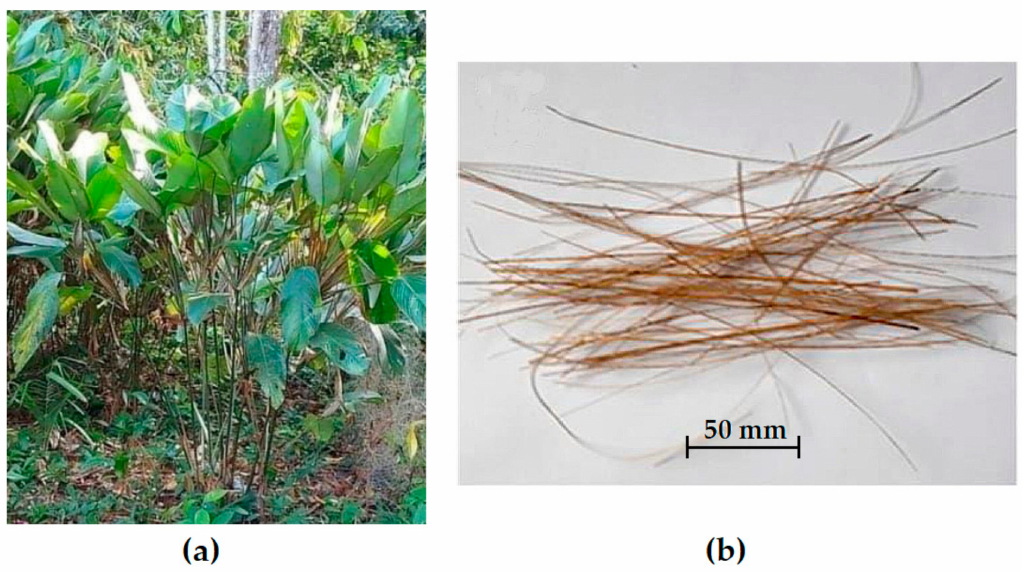
Figure 2. Guaruman: ( a ) plant and ( b ) fibers extracted from splinted stem (adapted from Reis et al.